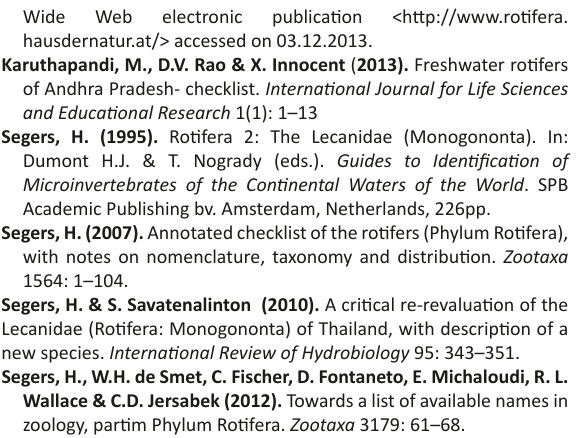
Figure 12. Lecane closterocerca (Schmarda)